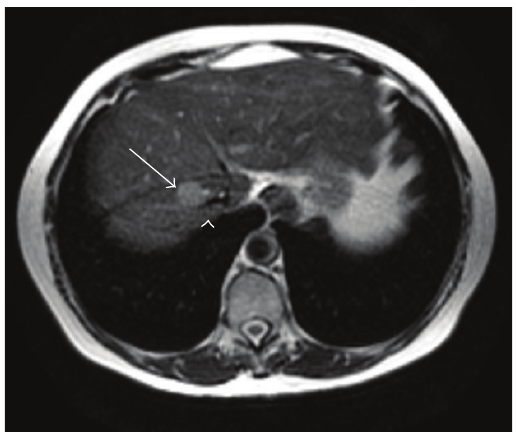
Figure 1: T2 weighted Magnetic Resonance image showing a tumor (arrow) compressing the RHV (arrow head).